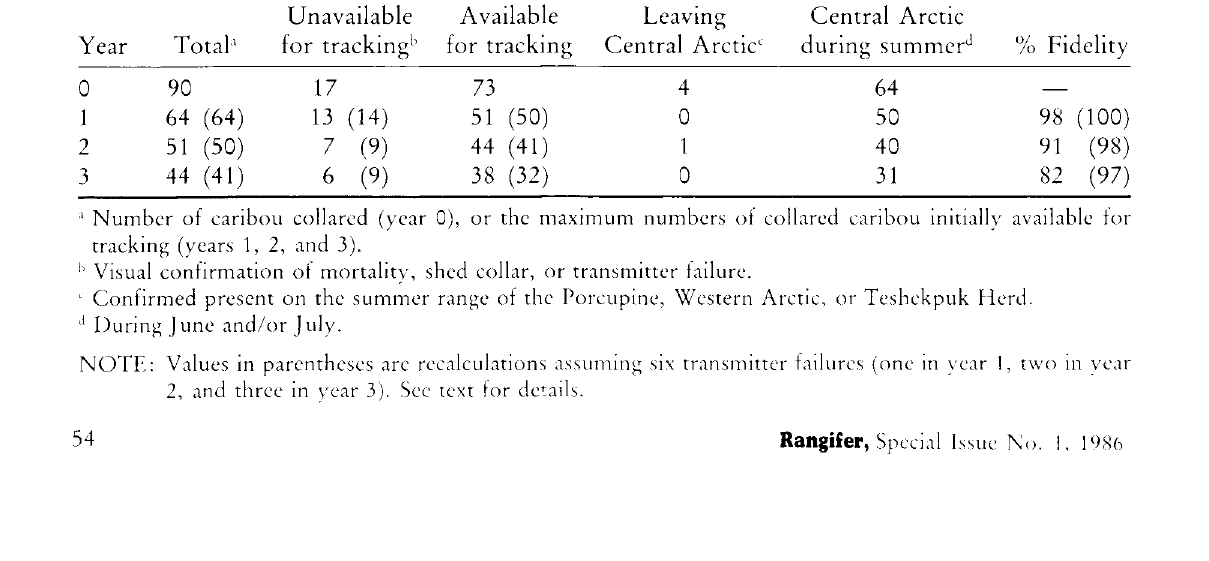
Table 2. Analysis across years of the fidelity of radio-collared female caribou to the Central Arctic region (Fig. 1), Alaska, during